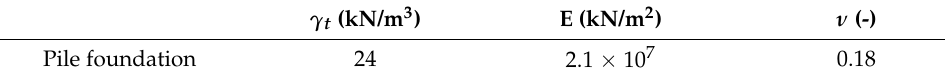
Table 2. Parameters of the pile foundation used for the analysis.